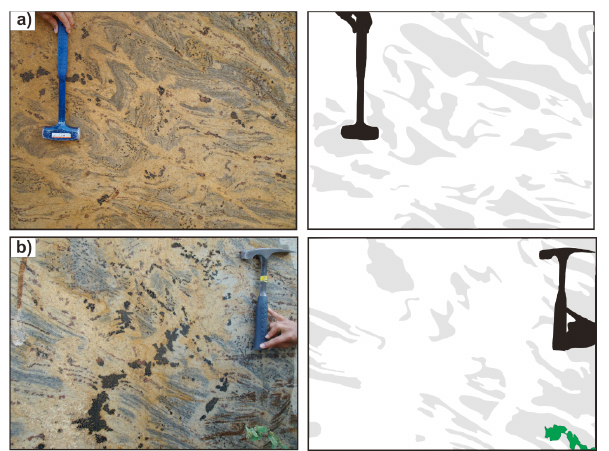
Figure 4. Pictures (left) and schematic drawing (right) of partially molten kinzigites of the Araçuaí belt. White represents the in situ leucosomes and gray represents the residuum and/or paleosome portions.